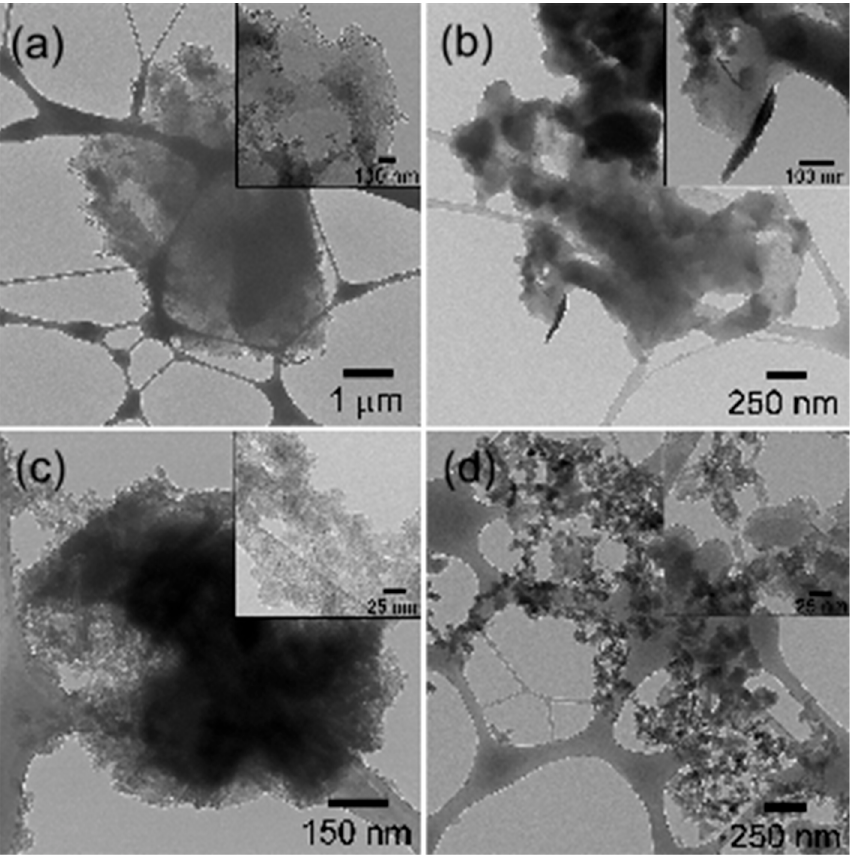
Figure 6. Micrographs of ( a ) Fib, ( b ) Fib-NH 2 , ( c ) Fib- g -PAni 1:0.5 and ( d ) Fib- g -PAni 1:1.